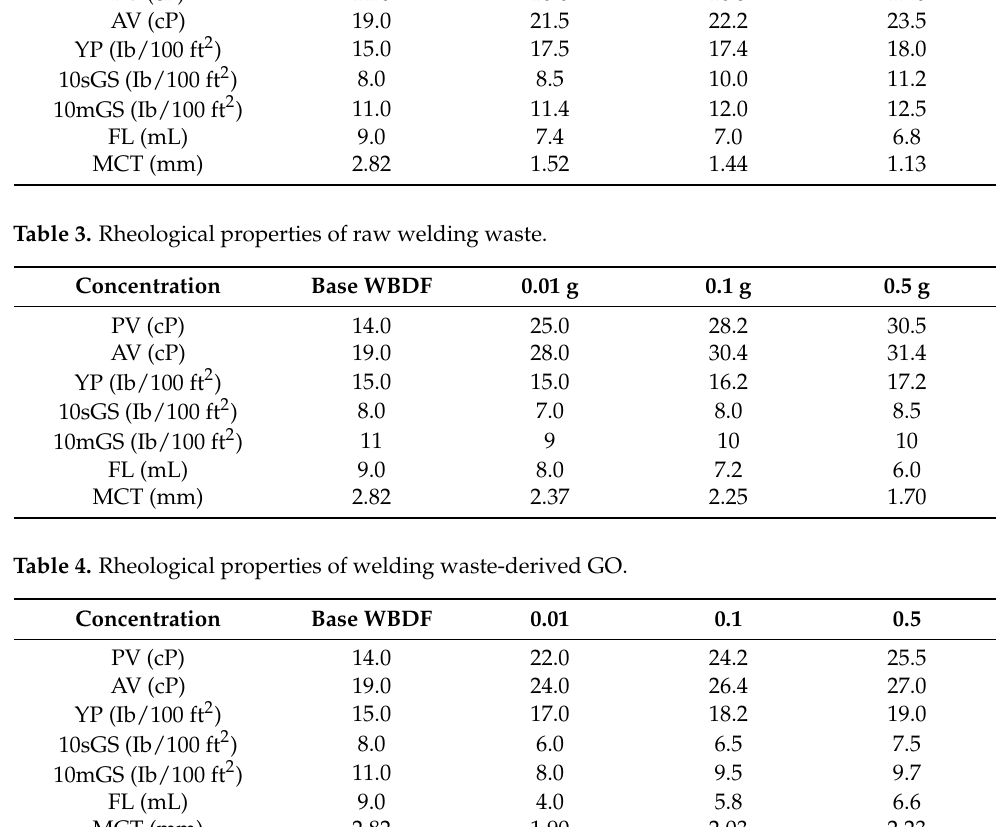
Table 2. Rheological properties of commercial GO.